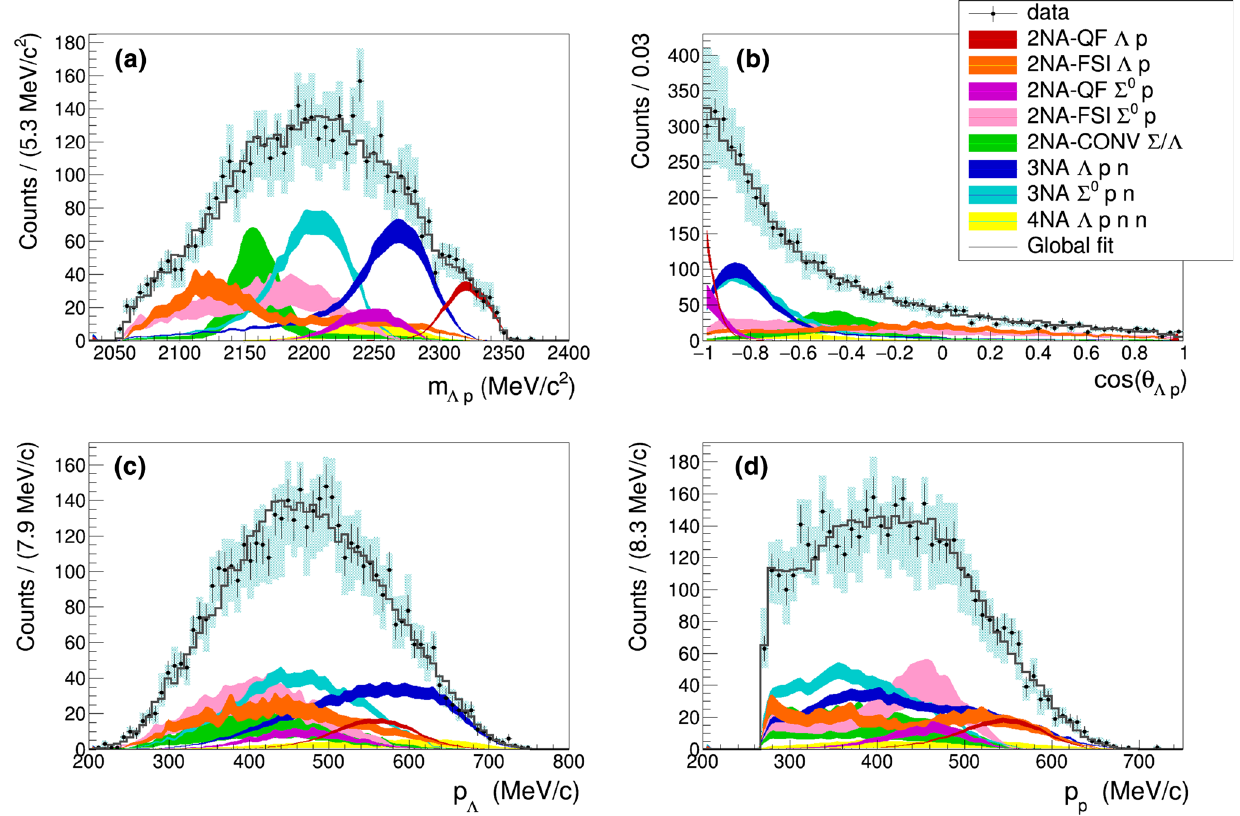
Fig. 4 (cid:2) p invariant mass ( a ), (cid:2) p angular correlation ( b ), (cid:2) momen- tum ( c ) and proton momentum ( d ) distributions are reported for the K − absorption on 12 C listed in the legend. Black points represent the data, black error bars correspond to the statistical errors, cyan error bars cor-